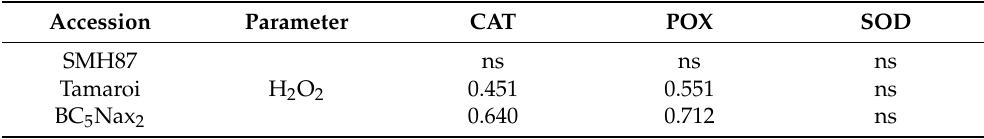
Table 3. Pearson coefficients of linear correlation ( p < 0.05) between H 2 O 2 and antioxidant enzyme activity in the leaves of three durum wheat accessions.